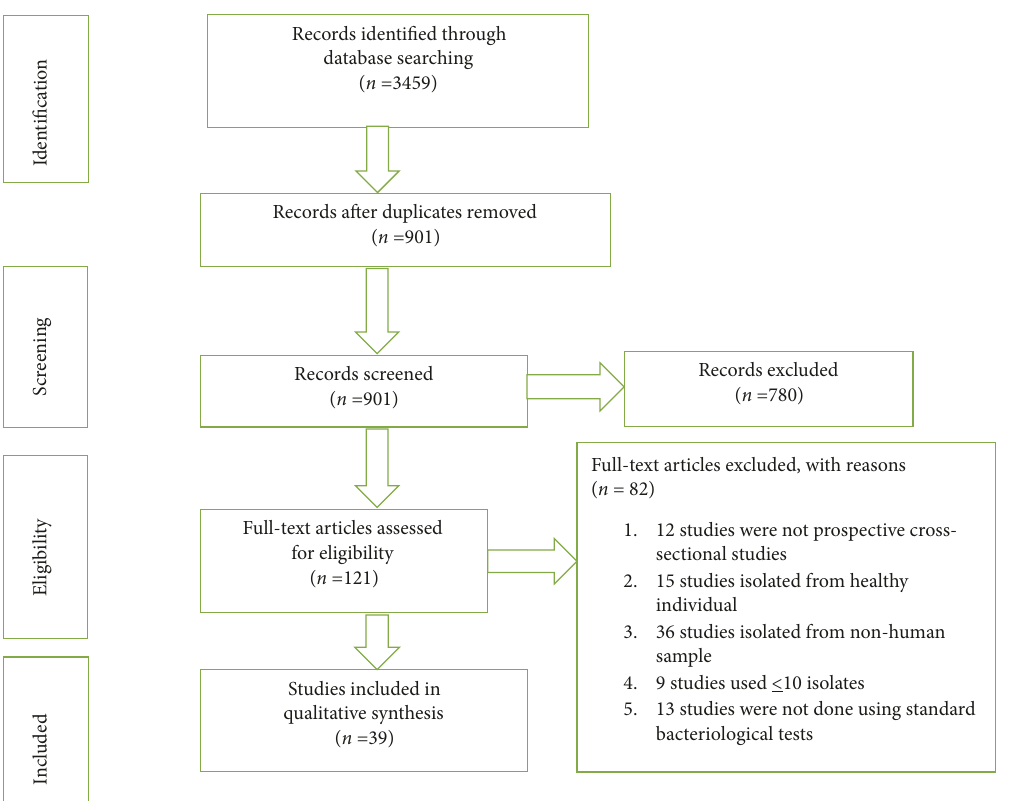
Figure 1: A flow diagram of the selection of eligible studies. The flow diagram shows the procedure of selecting an eligible study to undergo the systematic review. To perform this we start by identifying 3459 studies using a web-based search and goes to a screening of 901 studies after removing duplicates. Using eligibility criteria only 121 studies went to eligibility testing. Finally, 39 studies were